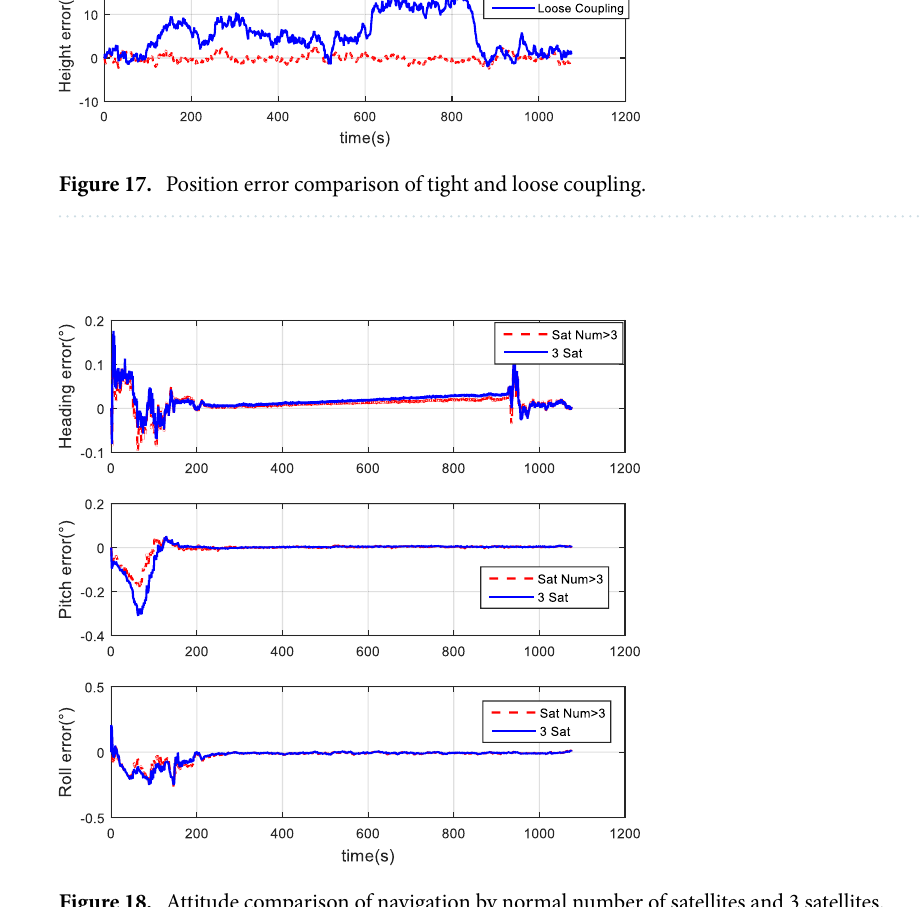
Figure 18. Attitude comparison of navigation by normal number of satellites and 3